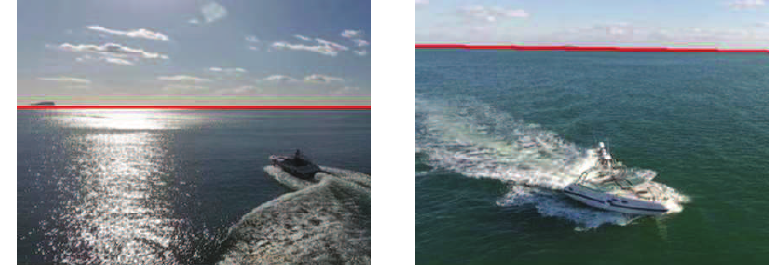
Figure 9. The effect of sea–skyline detection. Table 5. Comparison of detection accuracy of sea antenna after dehazing in different networks.